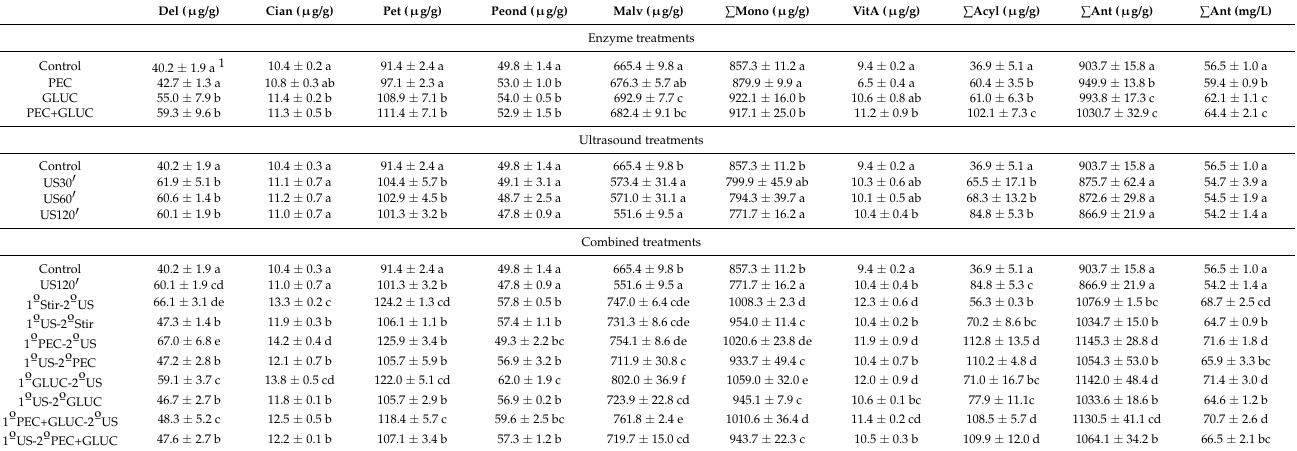
Table 1. Effect of the addition of enzymes and application of ultrasound in the release of antho- cyanins from red wine lees. Characterization and quantification of anthocyanins in solution ( µ g/g ± standard deviation).